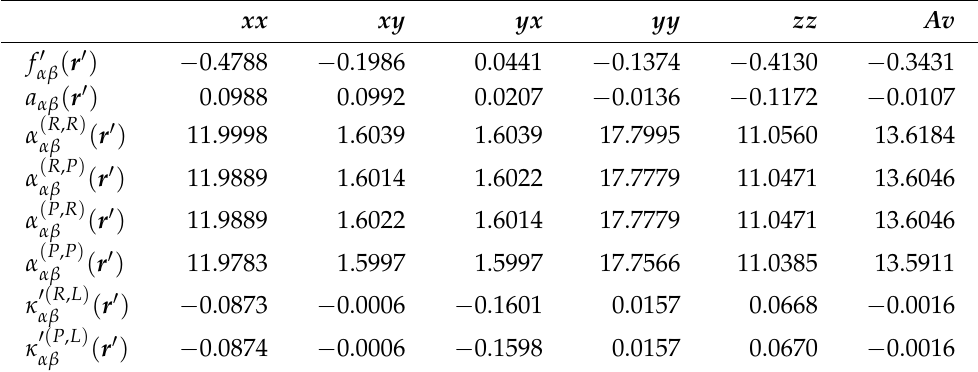
Table 1. Molecular tensors evaluated at λ = 589.3 nm, in atomic